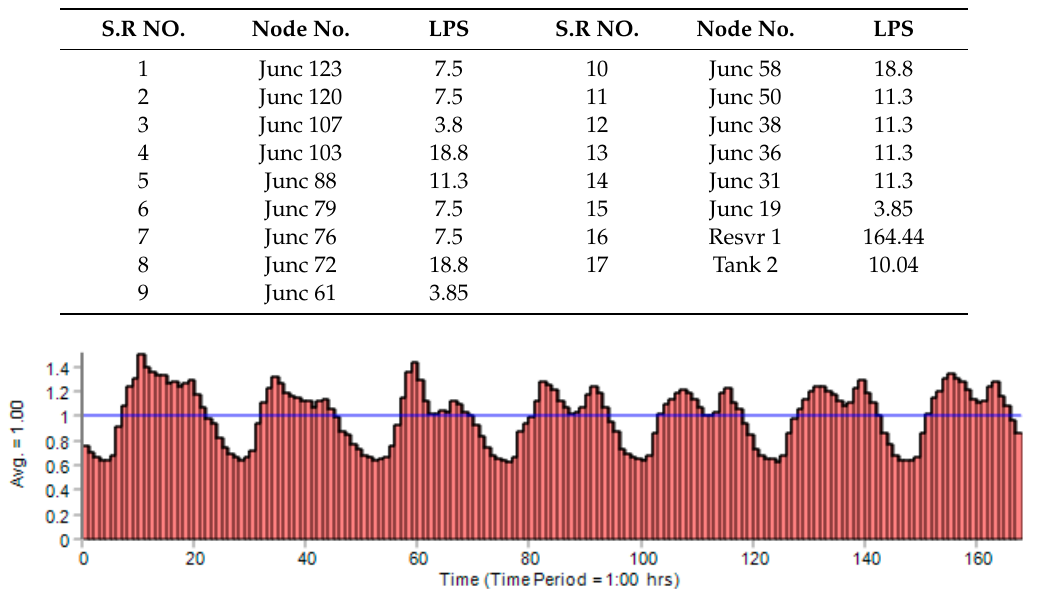
Figure 2. Campos do Conde II water distribution network [23]. Table 1. Base demand for various nodes [23].